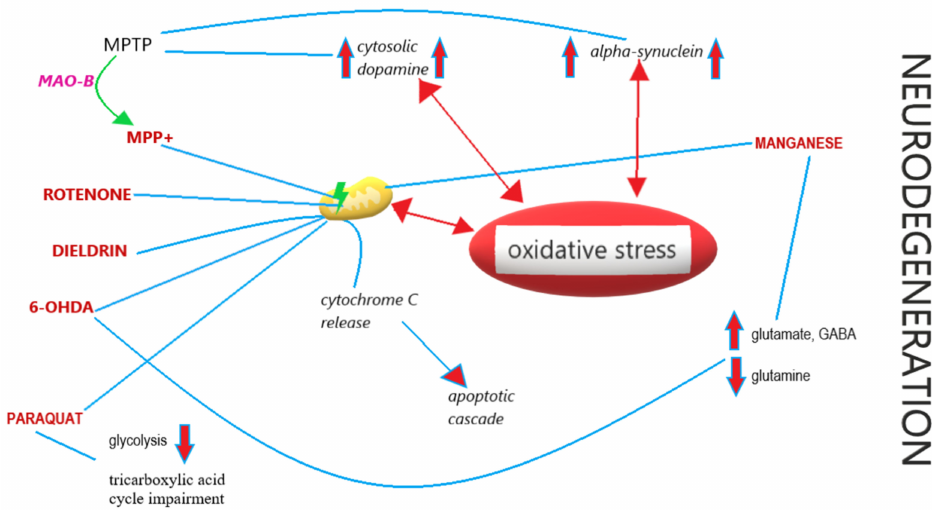
Figure 2. Mechanisms of toxin-induced